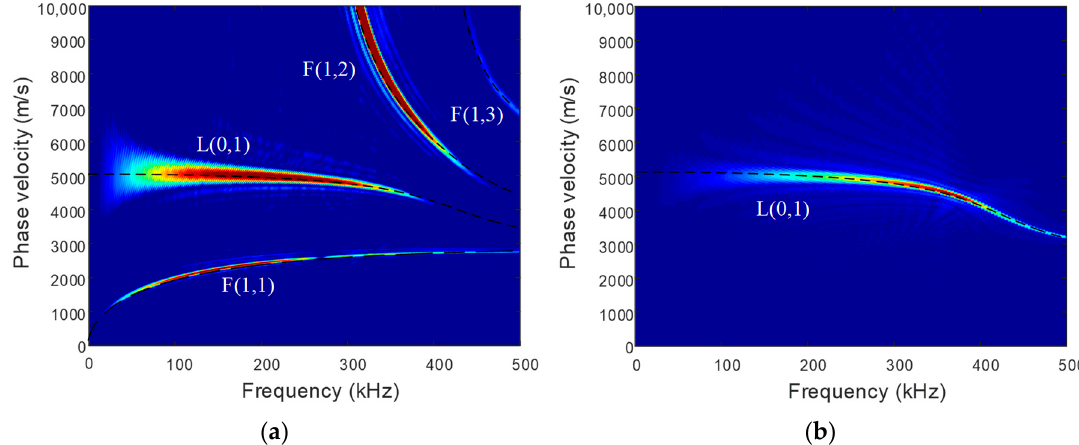
Figure 7. The phase velocity dispersion spectra obtained from nodal accelerations with different excitation methods: ( a ) an oblique triangular pulse signal with three equal components, and ( b ) a perpendicular triangular pulse signal with a z -axial component. The theoretical phase velocity dispersion curves obtained in Figure 1a are represented by the black dotted lines.